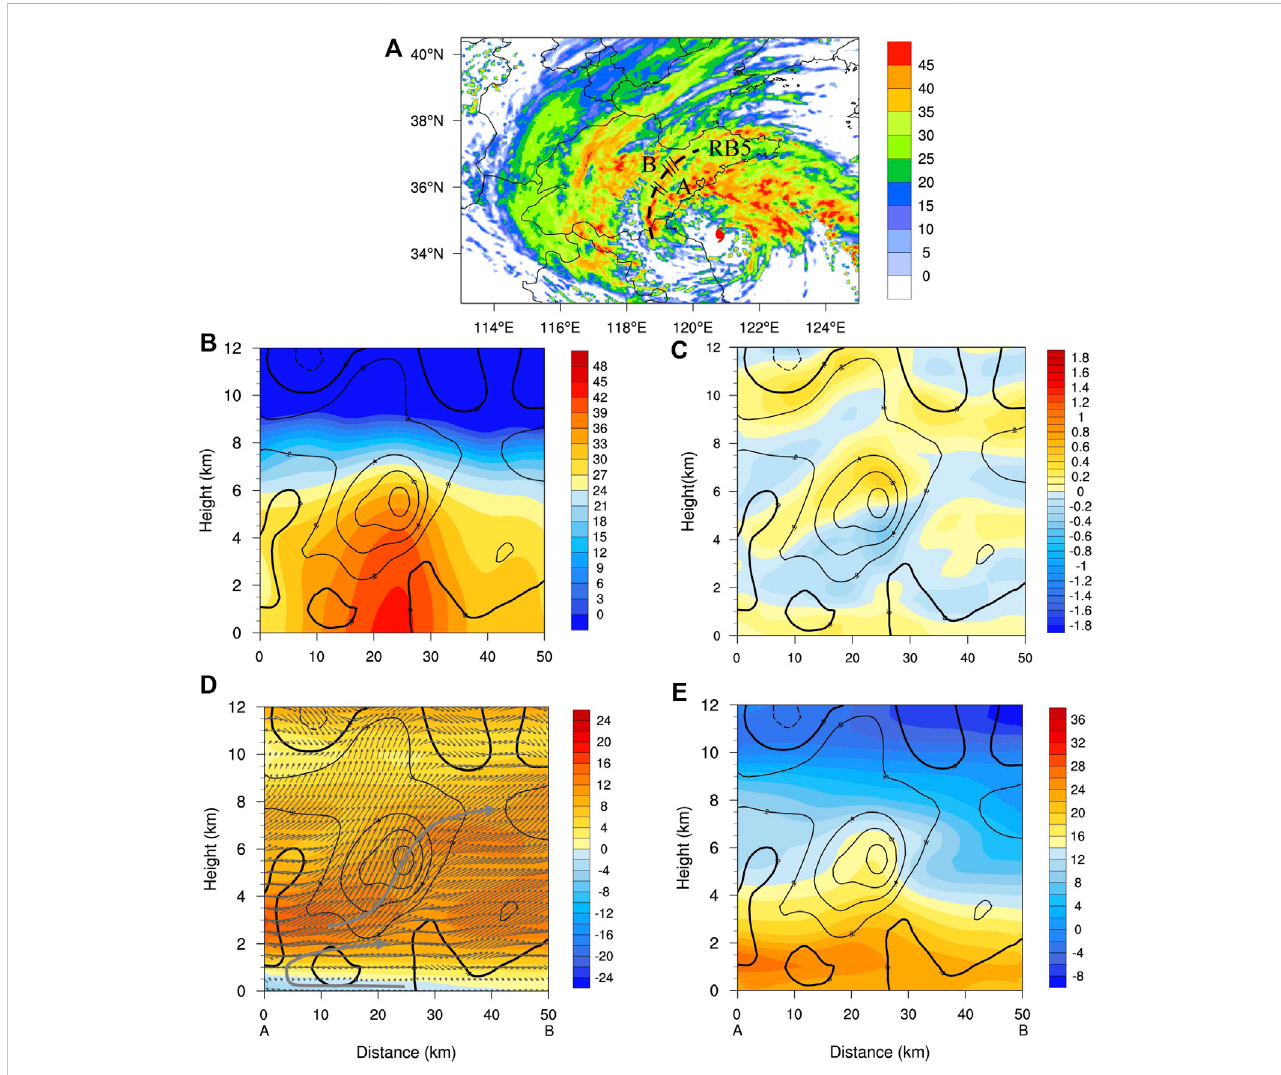
FIGURE 13 (A) Composite re fl ectivity (shaded; unit: dBZ) at 0645 UTC 11 August 2019; the black dashed line indicates the position of the rainband, the typhoon symboldenotesthelocationofLekima ’ scenter,andblacksolidlinesindicatethepositions ofradius – heightcross-sectionstakenin (B – E) .Theaverageof fi ve radius – heightcross-sectionsofverticalvelocity(contourswithintervalof.2,positivevaluesareinsolidcontours,negativevaluesareindashedcontours,zero valuesareinboldcontours;unit:m/s)with (B) re fl ectivity(shaded;unit:dBZ); (C) horizontaldivergence(shading;10 − 3 s − 1 ); (D) radialvelocity(shaded;unit: m/s)andwinds(vectors);and (E) tangentialvelocity(shaded;unit:m/s)fromD02simulation,x-axiscoordinateisthehorizontaldistancefromA(unit:km),and y-axis coordinate is the height (unit: